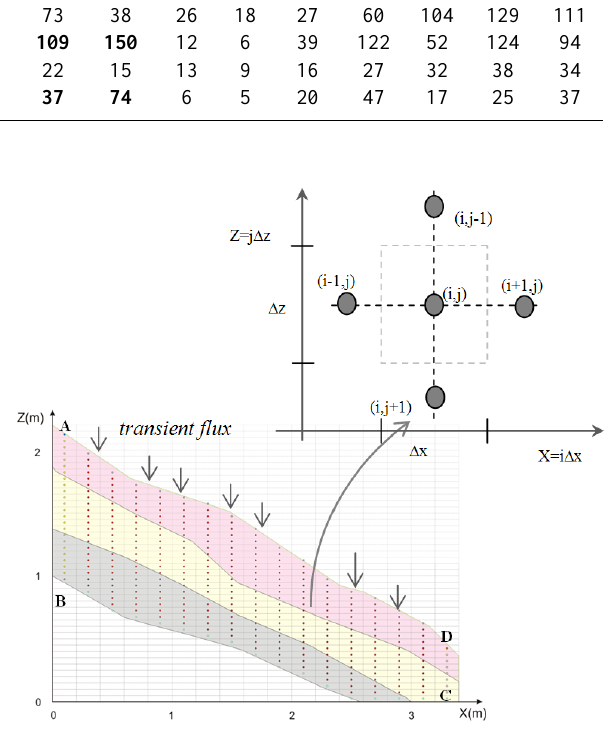
Figure 5. Nodal network implemented for development of FDM